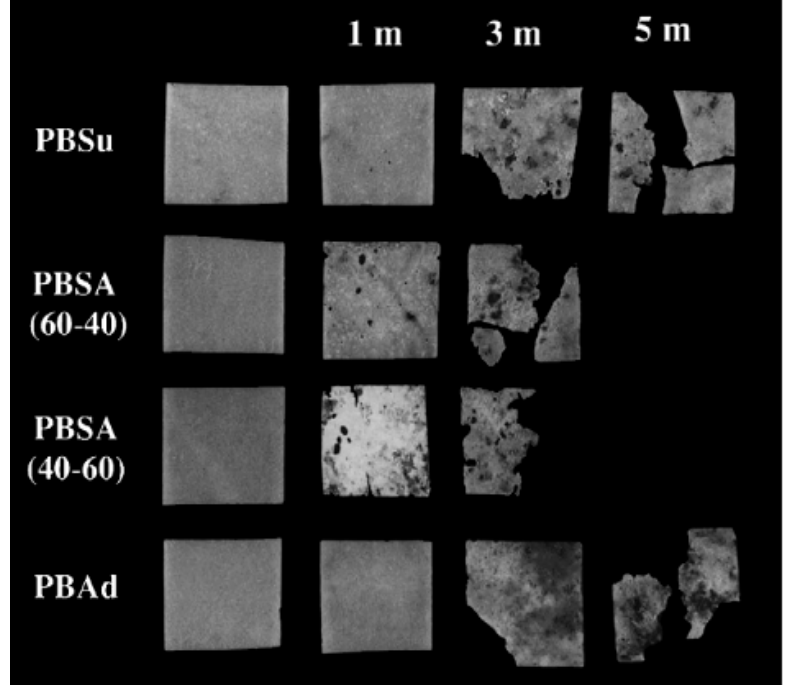
Figure 11. PBS and PBSA-based blends after soil burial treatment for 1, 3, and 5 months [Reprinted with permission from Reference [45] Copyright 2006 Elsevier].